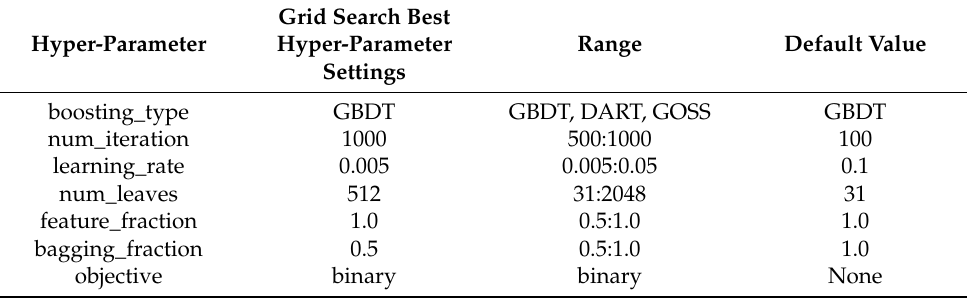
Table 3. LightGBM Grid Search Hyper-parameter Results (Ember Dataset).